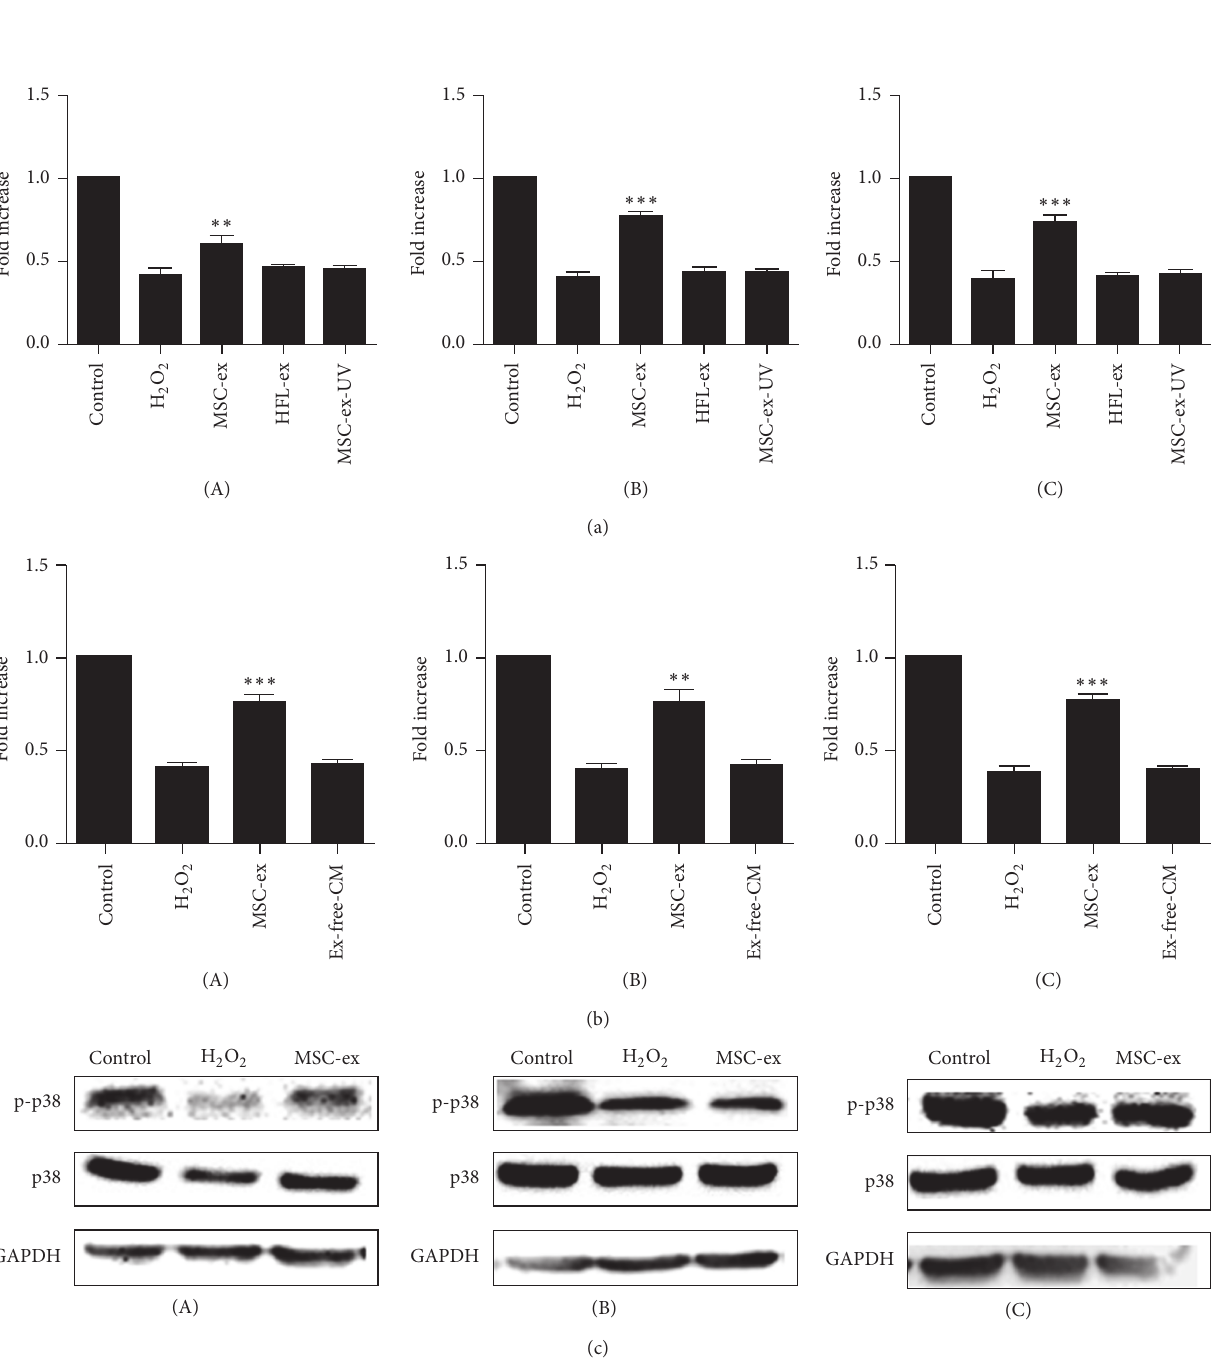
Figure 3: HucMSCs-exosomes protect cell viability in vitro . (a) MTT assay. H9C2(2-1), HL-7702, and NRK-52E cells were pretreated with different sources of hucMSCs-exosomes (800 𝜇 g/mL) for 24 hours, followed by exposure to H 2 O 2 (300 𝜇 M) for 24 hours. Results were shown as mean ± SD ( 𝑛 = 5 ). ∗∗ 𝑝 < 0.01 and ∗∗∗ 𝑝 < 0.001 compared to H 2 O 2 group. (b) MTT assay. H9C2(2-1), HL-7702, and NRK-52E cells were pretreated with different sources of hucMSCs-exosomes (800 𝜇 g/mL) or exosomes-free conditioned medium collected from hucMSCs (EX-free-CM) for 24 hours, followed by exposure to H 2 O 2 (300 𝜇 M) for 24 hours. Results were shown as mean ± SD ( 𝑛 = 5 ). ∗∗ 𝑝 < 0.01 and ∗∗∗ 𝑝 < 0.001 compared to H 2 O 2 group. (c) Western blotting analysis of phosphorylated p38. H9C2(2-1), HL-7702, and NRK-52E cells were pretreated with hucMSCs-exosomes (800 𝜇 g/mL) followed by exposure to H 2 O 2 as described